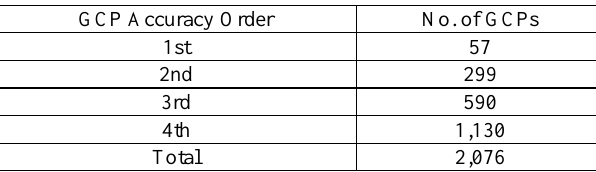
Table 1. Number of GCPs according to order of